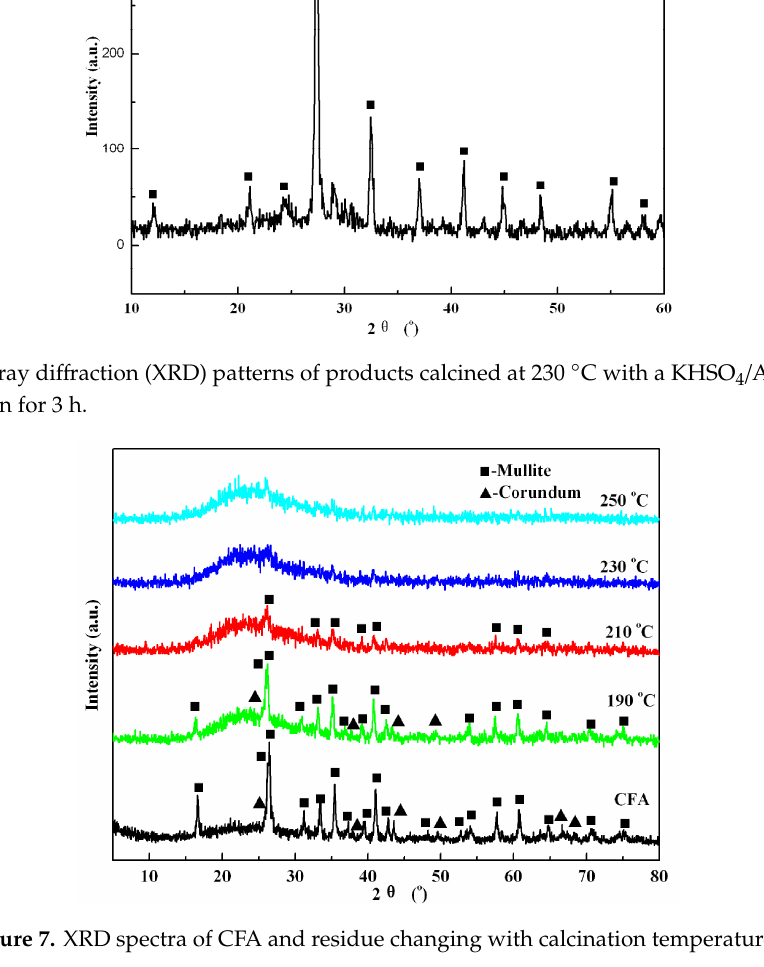
Figure 7. XRD spectra of CFA and residue changing with calcination temperatures.